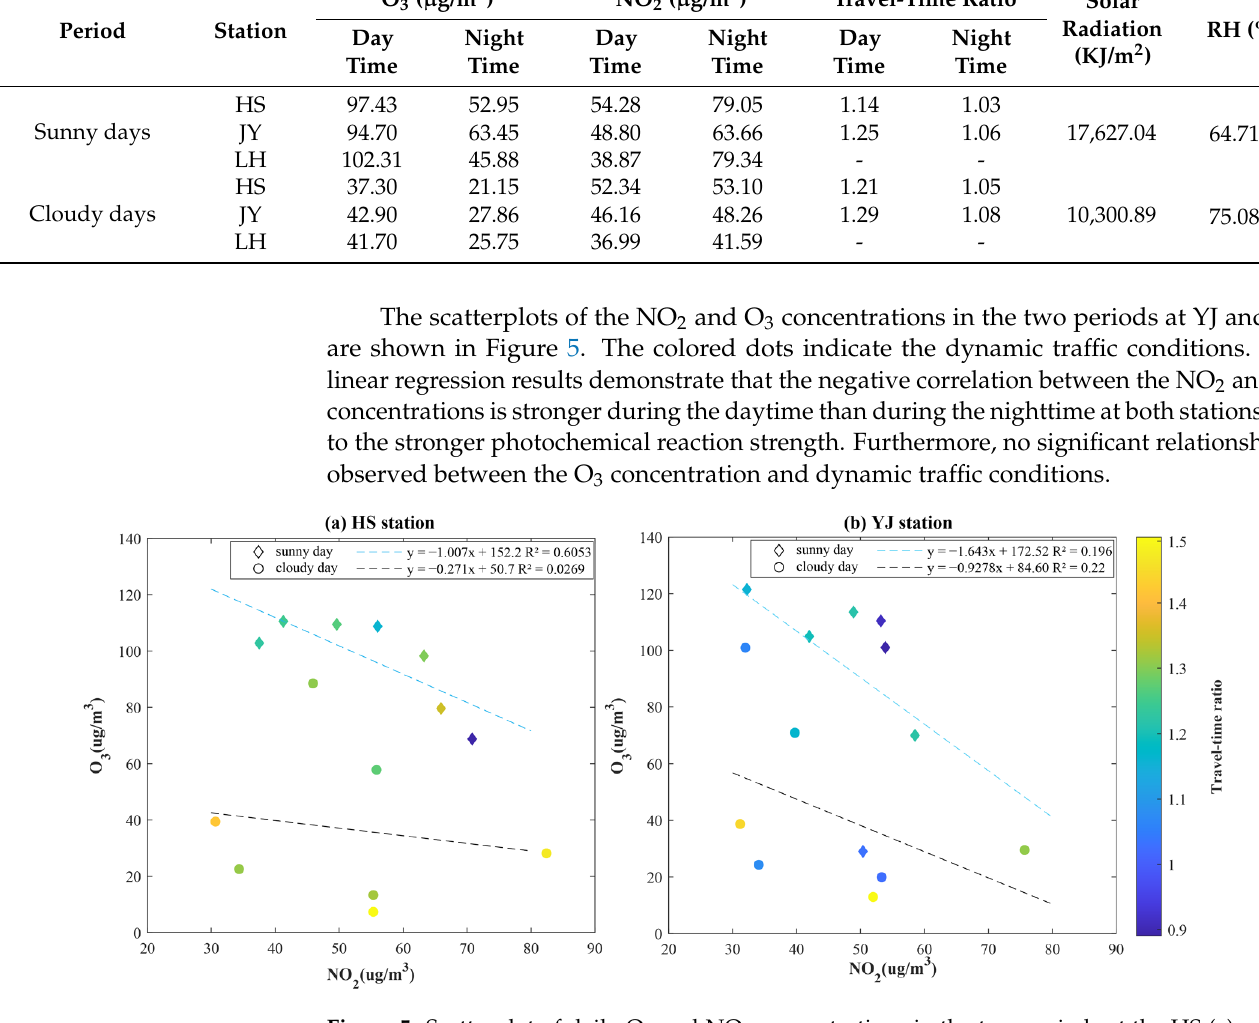
Figure 5. Scatterplot of daily O 3 and NO 2 concentrations in the two periods at the HS ( a ) and YJ ( b ) ( b ) stations. The colored dots denote the travel-time stations. The colored dots denote the travel-time ratio.